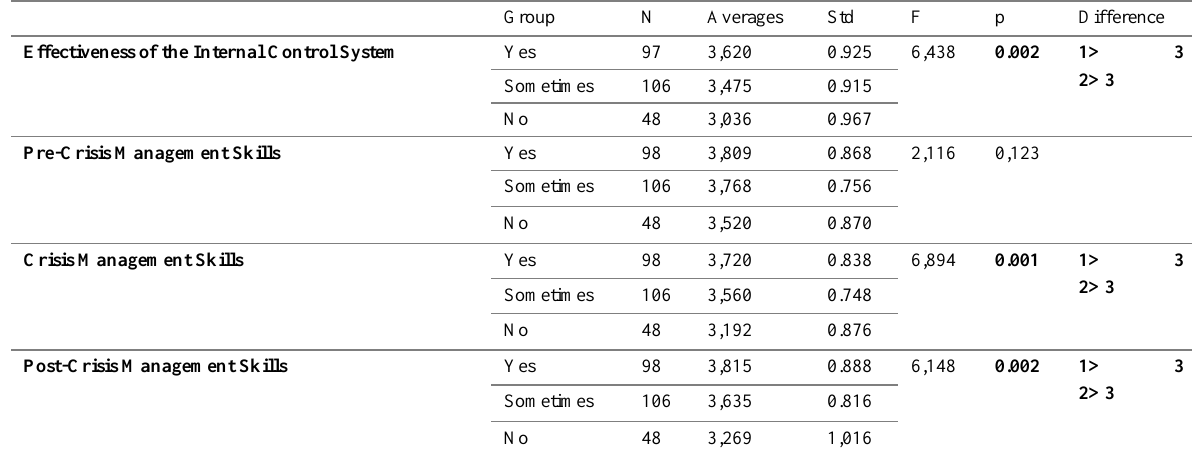
Table 12: ANOVA Participants of the Internal Control System and Crisis Management Effectiveness of the Skill Points edited by the Scientific Program Participation